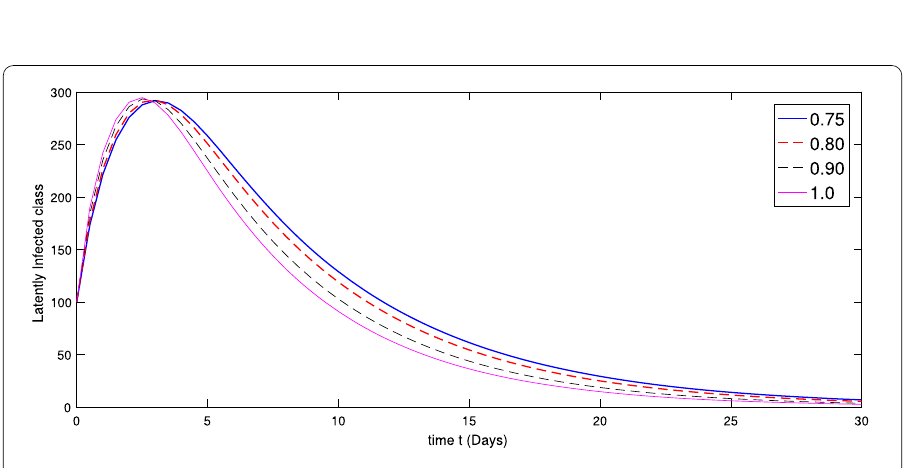
Figure 4 Graphical representation of approximate solutions up to five terms of latently infected population L ( t ) at different fractional order of the considered model (2)